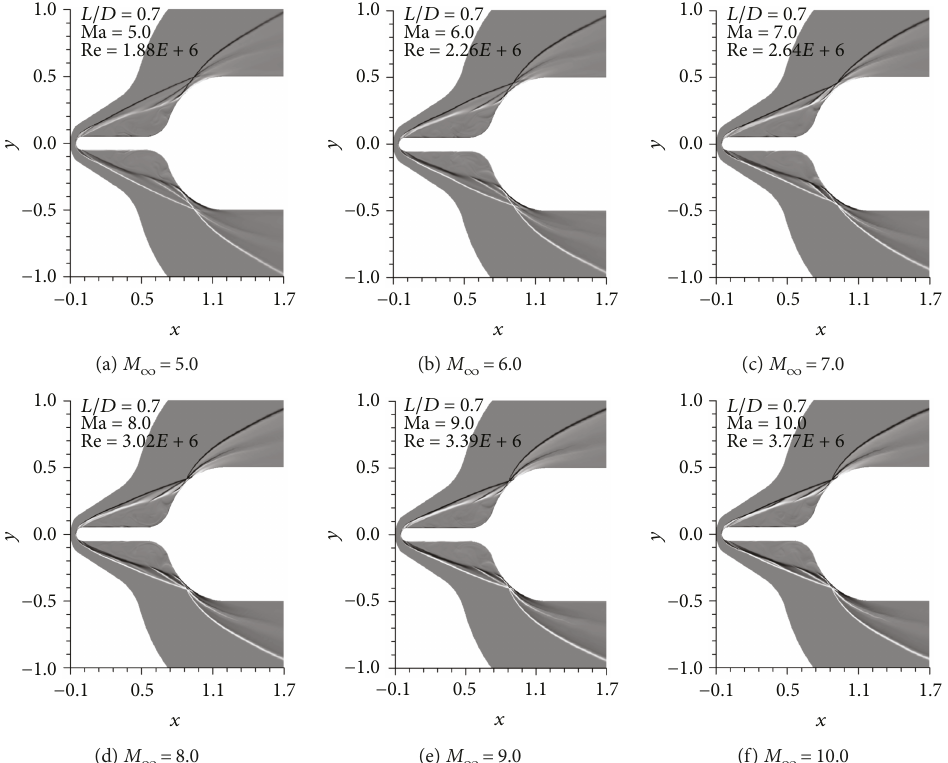
Figure 5: Flow fi eld density gradient in y direction of pure spiked blunt bodies. Spike length L/D = 0.7. L/D = 0.8 Ma = 5.0